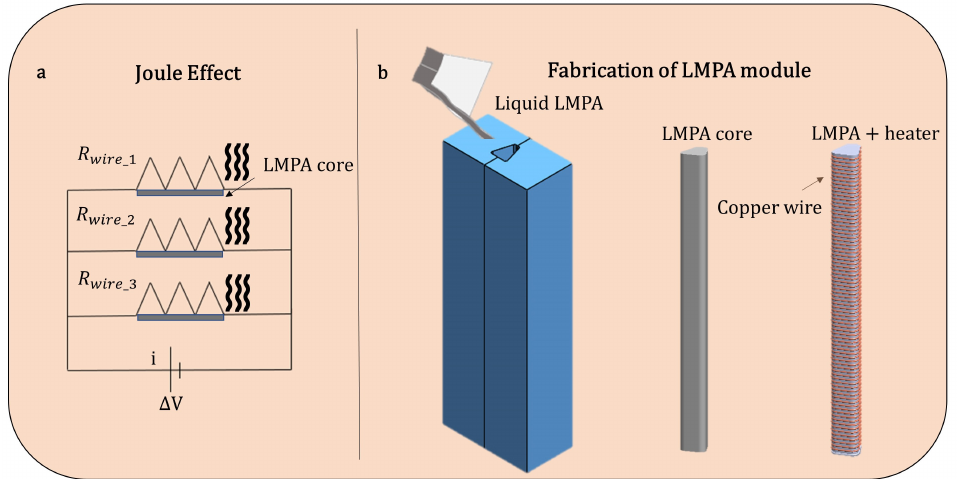
Figure A1. ( a ) Schematic representation of the heating system. ( b ) Substeps of step of the